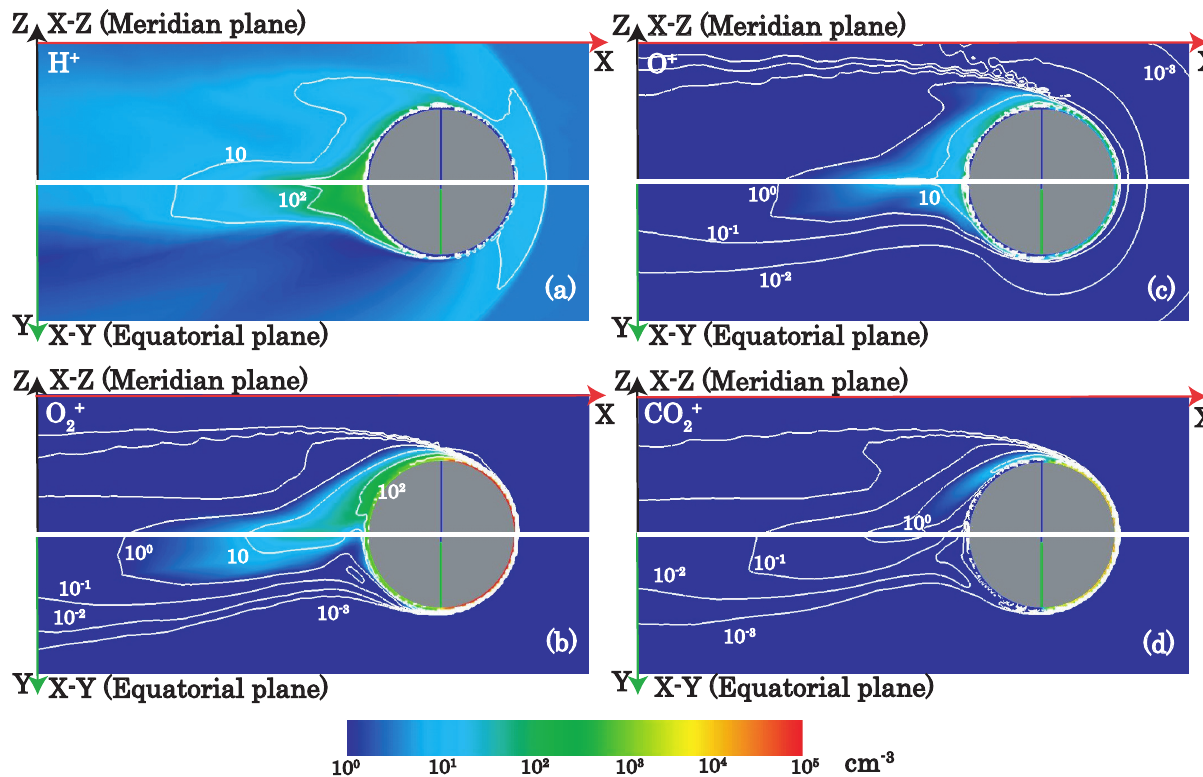
Fig. 3. The distribution of H + (top left), O + (top right), O + wind flows from the right. The top half of each panel represents the meridian plane, while the bottom half represents the equatorial plane.